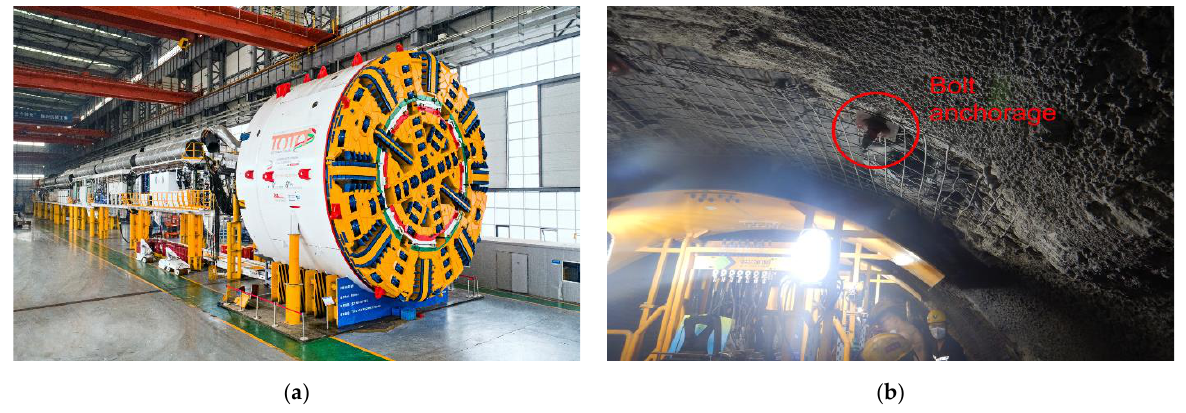
Figure 1. ( a ) TBM and ( b ) TBM-excavated tunnel with bolt anchorage.